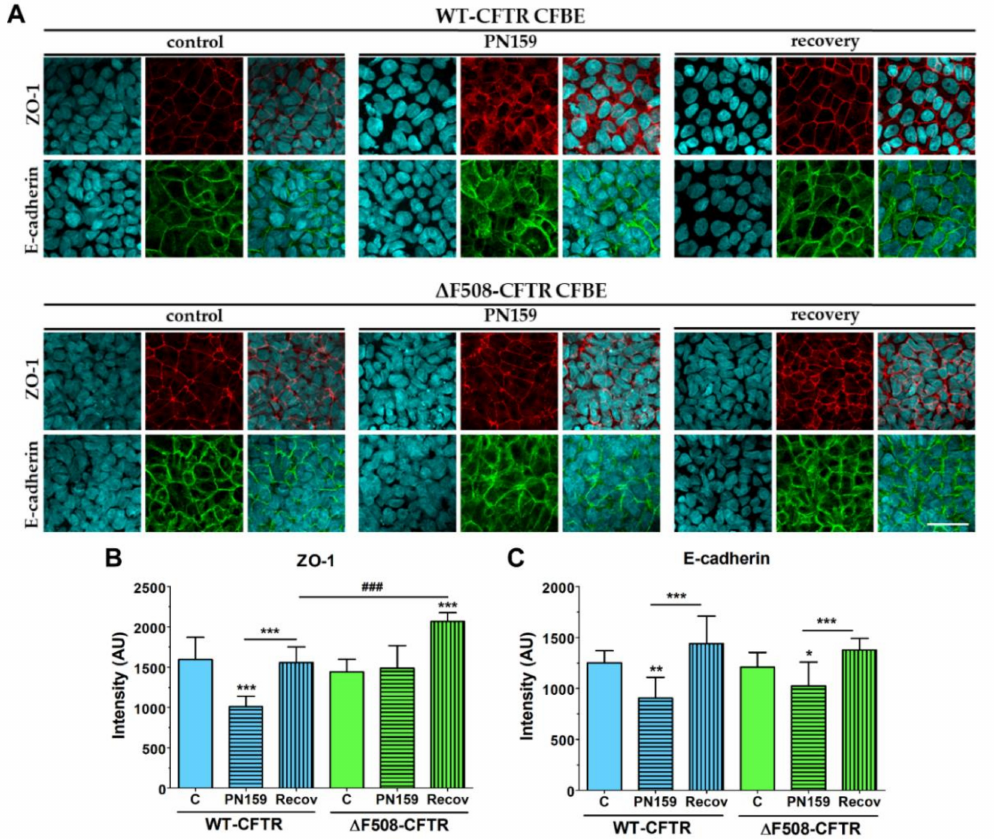
Figure 7. Immunostaining for junctional proteins ZO-1 and E-cadherin CFBE cells without or after a 30-min PN159 peptide treatment, and following a 24-h recovery period ( A ). The mean pixel intensity of ZO-1 ( B ) and E-cadherin ( C ) staining. Means ± SD, n = 3–6 / group. 2-way ANOVA & Bonferroni test. * p < 0.05, ** p < 0.01, *** p < 0.001 compared to the control and the treated group. ### p < 0.001 compared to wild-type epithelial cells. Green and red color: immunostaining for junctional proteins. Cyan color: staining of cell nuclei. Bar: 40 µ